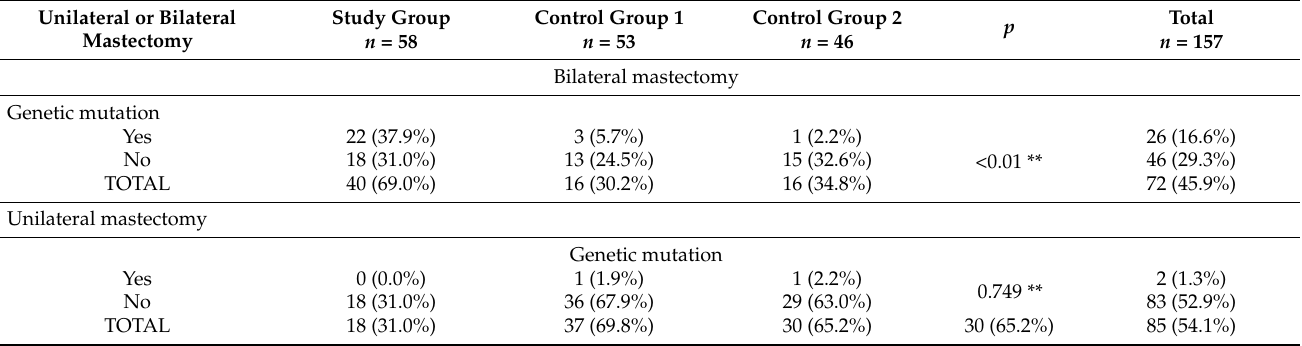
Table 4. Type of mastectomy according to the genetic study and treatment type.